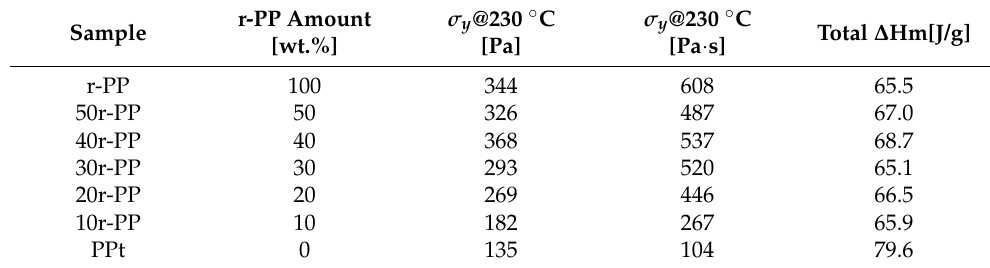
Table 3. Composition of PPt/r-PP blends, yield stress values, and total melting enthalpy of the studied materials. Data for base PPt and r-PP are also